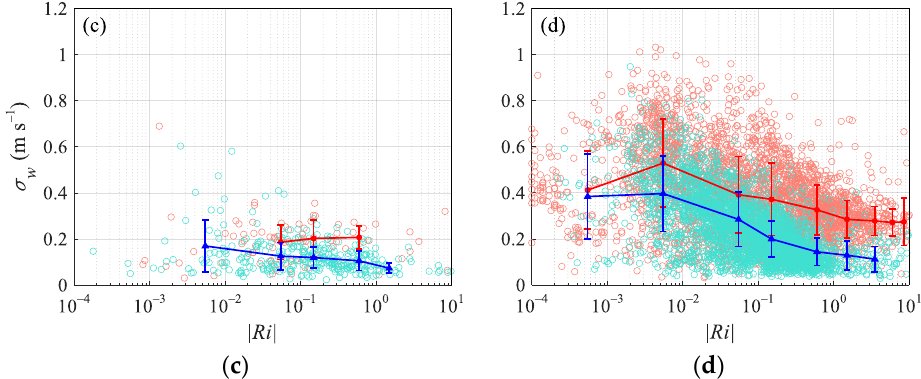
Figure 7. The dependence of the horizontal longitudinal wind standard deviation, σ w , on the stratification stability Ri ( a ) northwest, ( b ) northeast, ( c ) southwest, ( d ) southeast. The scattered points represent the average value of each record. The curves represent the average value of different Ri intervals, and the error bars represent the standard deviation of each interval. The unstable and stable conditions are indicated in red and blue colors, respectively.